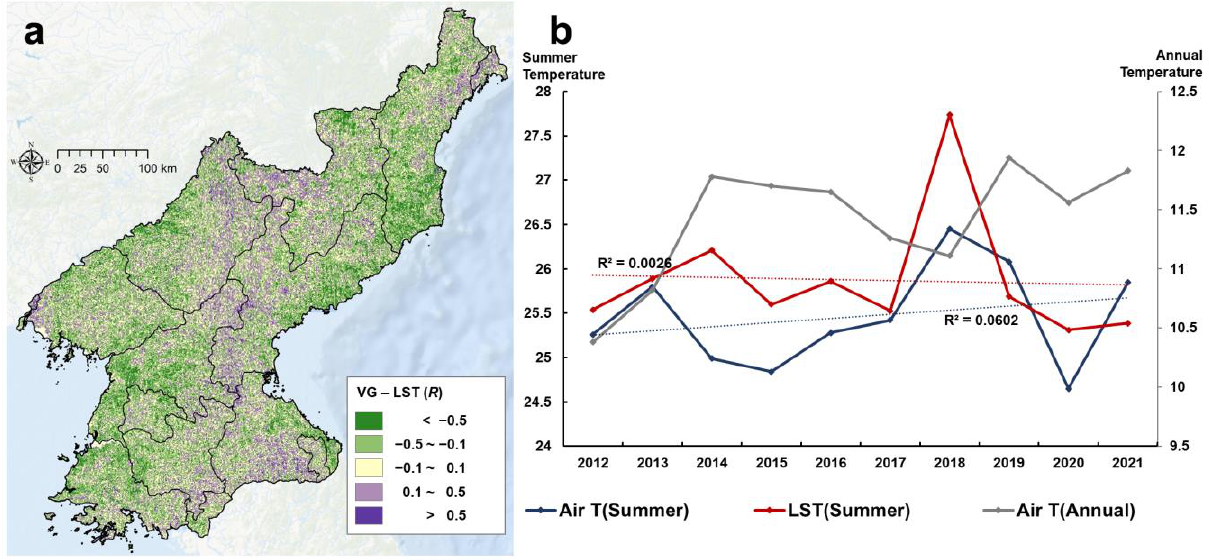
Figure 6. Spatial correlation with vegetation greenness and land surface temperature ( a ) and air temperature and surface temperature changes in the last 10 years ( b ). Table 2. Correlation coefficient of vegetation greenness and land surface temperature by